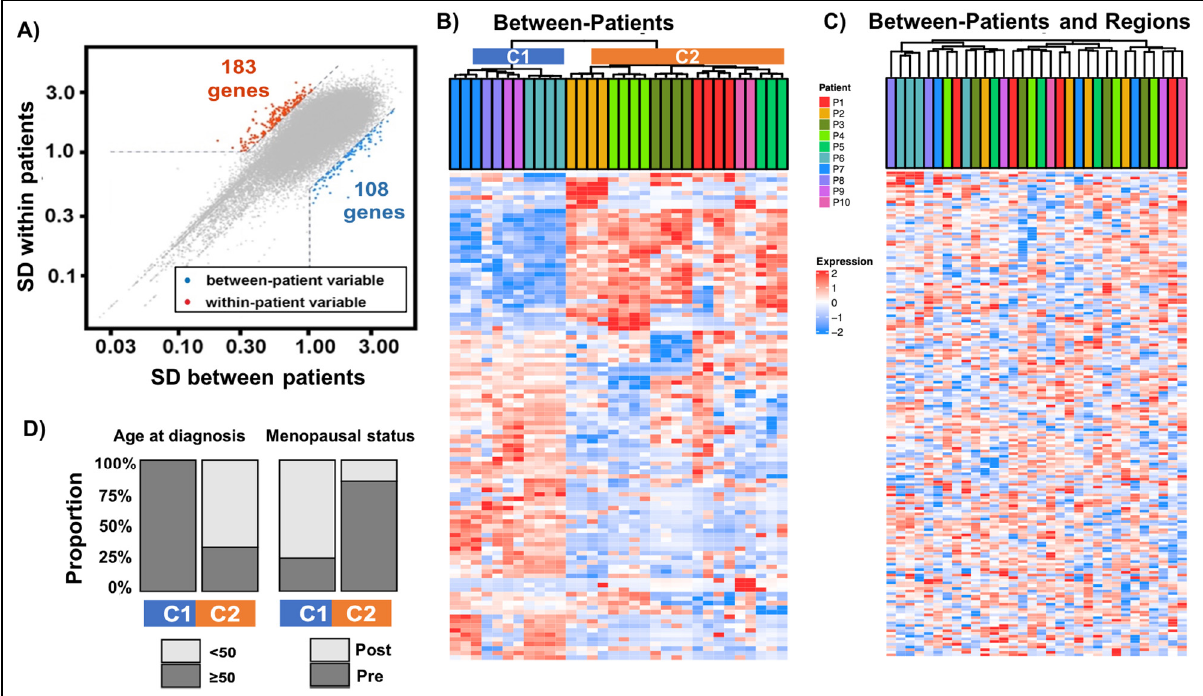
Figure 2. Gene expression heterogeneity between TNBC patients and regions characterizes patients based on age at diagnosis and post-menopausal status. ( A ) Selection of genes with high expression variability between patients and across regions. Scatterplot of standard deviations (SD) of gene expression between patients and between regions. In red are 183 genes with within-patient gene expression variability greater than one and greater than or equal to nine times the estimated between- patient variability. In blue are 108 genes with between-patient expression variability greater than one and greater than or equal to four times the estimated within-patient variability. ( B , C ) Unsupervised clustering of genes characteristic of between-TNBC patients versus between-TNBC patients and regions. RNA expression data (log2[CPM + 1]) were scaled in rows and columns and were clustered using Ward’s algorithm based on Euclidean distance. The heatmap of 108 genes characterizing between-patient differences ( B ) shows two main patient clusters: C1 (blue, n = 4 patients) and C2 (orange, n = 6 patients). The heatmap of 183 genes characterizing between patient and region differences ( C ) shows clusters of regions from the same tumor (with the exception of one patient). ( D ) Distribution of significant ( p < 0.05) patient and tumor characteristics associated with between- TNBC patient clusters represented by colored bars.